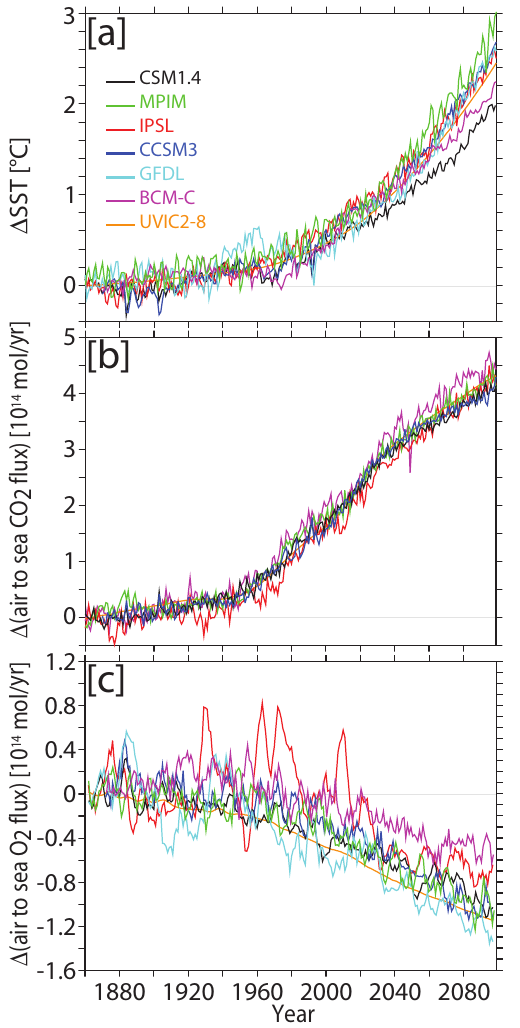
Fig. 5. Changes in sea surface temperature (a) , air–sea CO 2 flux (b) and air–sea O 2 flux (c) for the global ocean over the period 1860–2100.